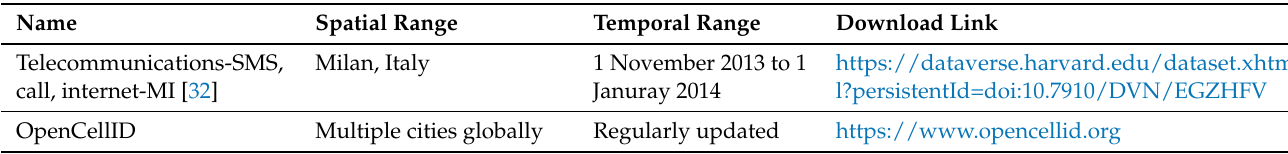
Table 3. The list of CDR